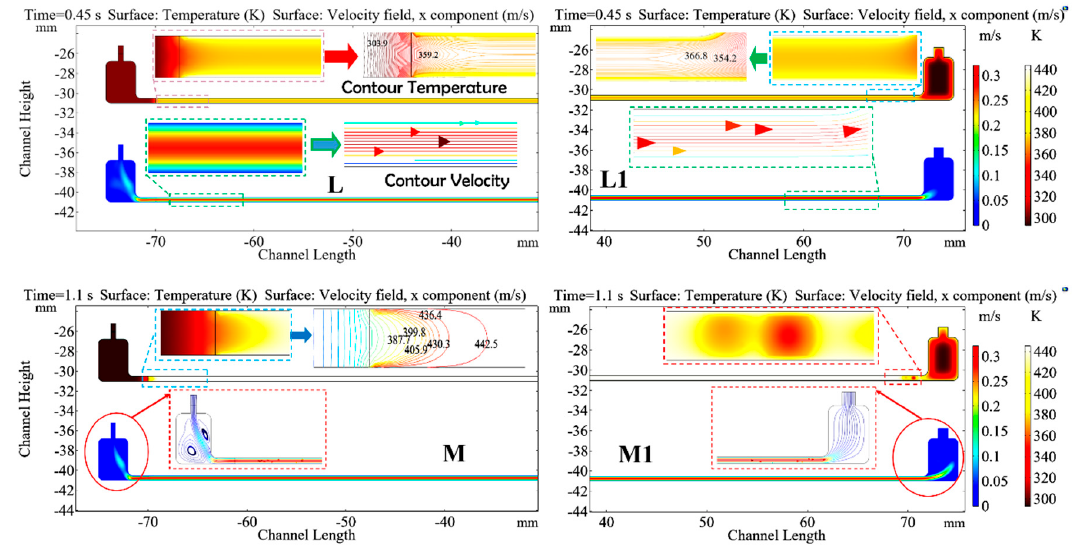
Figure 7. Heat transfer of fluids in the approximate model of two-phase flow from t = 0.45 s to t = 1.1 s with the uniform temperature at the walls: [L-M] Channel inlet, [L1-M1] Channel outlet, contour (values are plotted randomly).